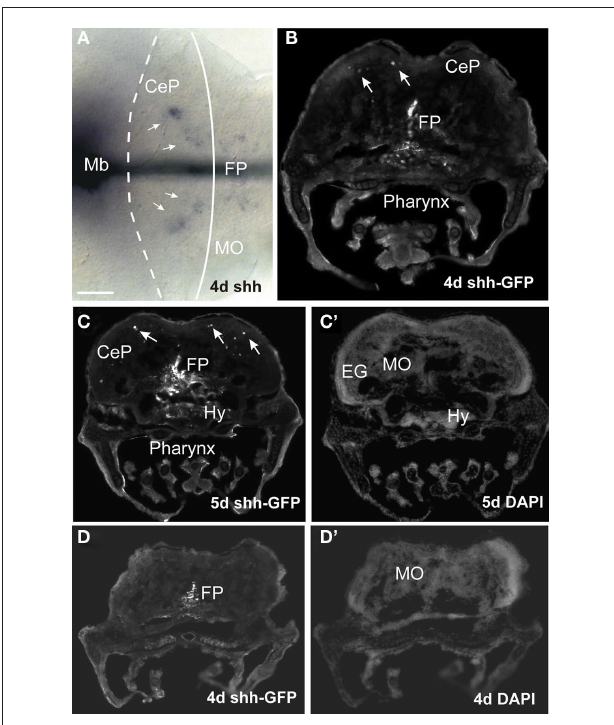
Figure 6 | expression of sonic hedgehog in larval zebrafish cerebellar plate. (A) Whole mount shows midbrain and hindbrain expression of shh (ISH, performed as described in Volkmann et al., 2010). (B–D) Transverse sections at cerebellar plate (B,C) and medullary (D) levels from transgenic Tg( 2.4shha-ABC:GFP )sb15 zebrafish (line originally published as Tg( 2.2shh:gfpABC#15 ) by Shkumatava et al., 2004). Note GFP + cells in floor plate and sparsely in cerebellar plate (arrows). (C ′ ,D ′ ) Identical sections in DAPI stain. Methodological details will be reported elsewhere. CeP, cerebellar plate; EG, eminentia granularis; FP, floor plate; Hy, hypothalamus; Mb, midbrain; MO, medulla oblongata.